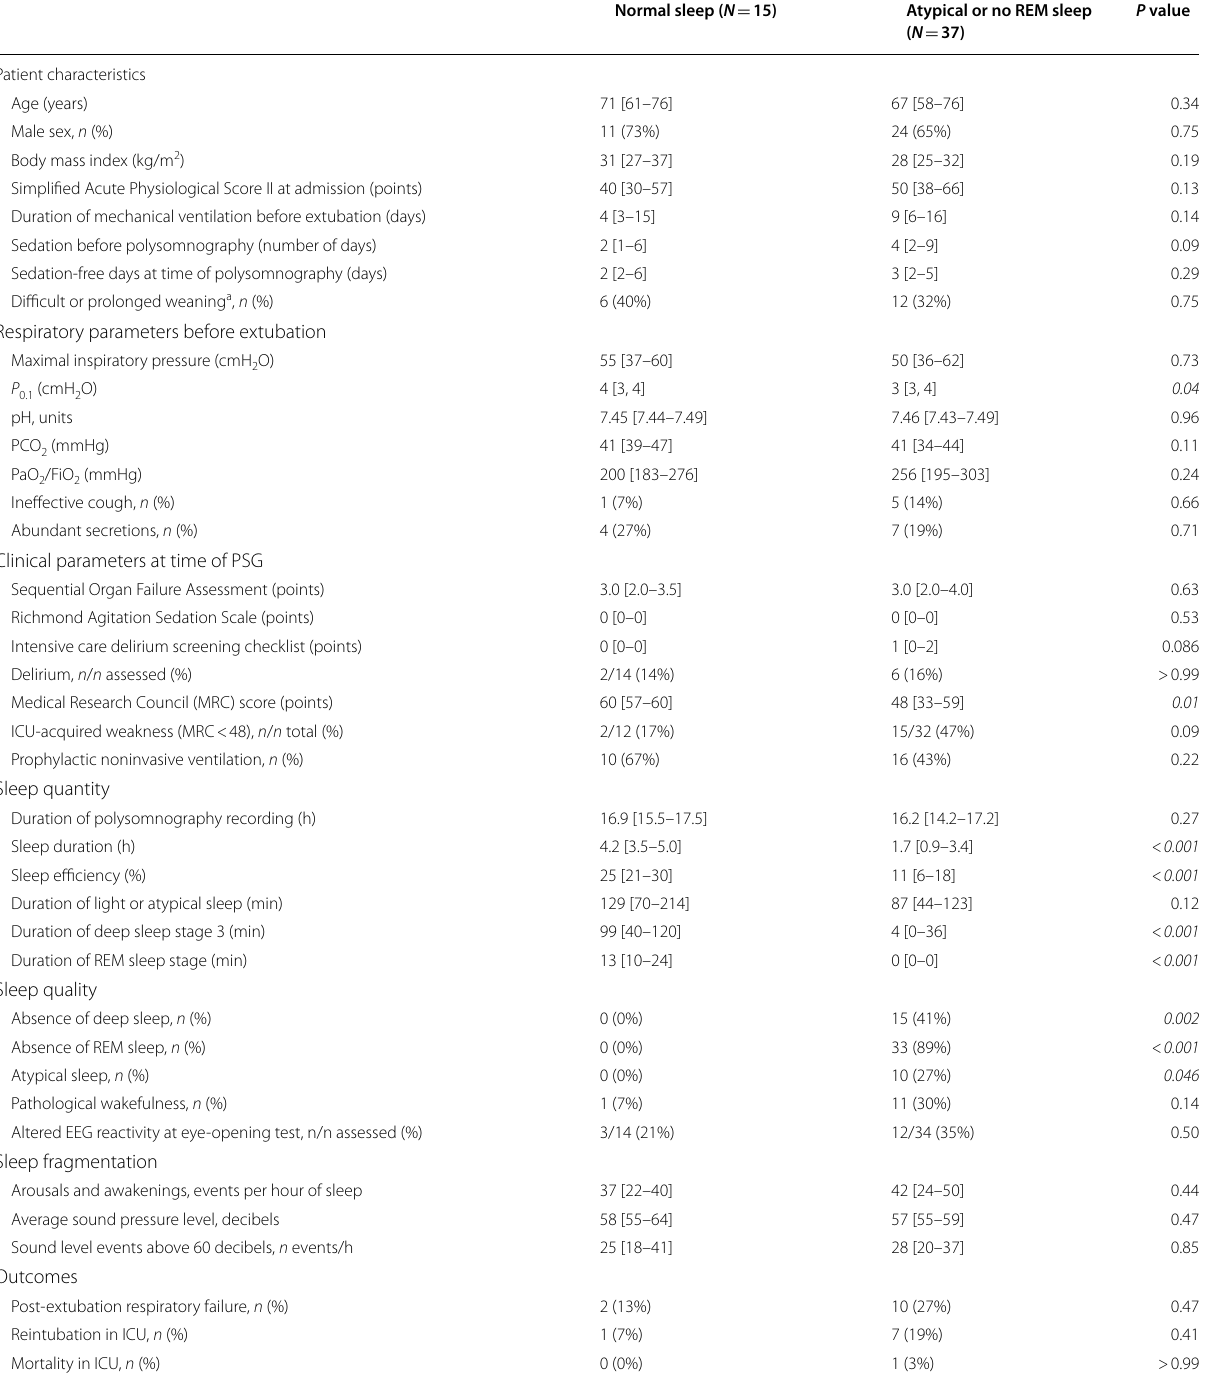
Table 2 Comparison of patients with normal sleep architecture and those with atypical sleep or no rapid eye movement (REM)